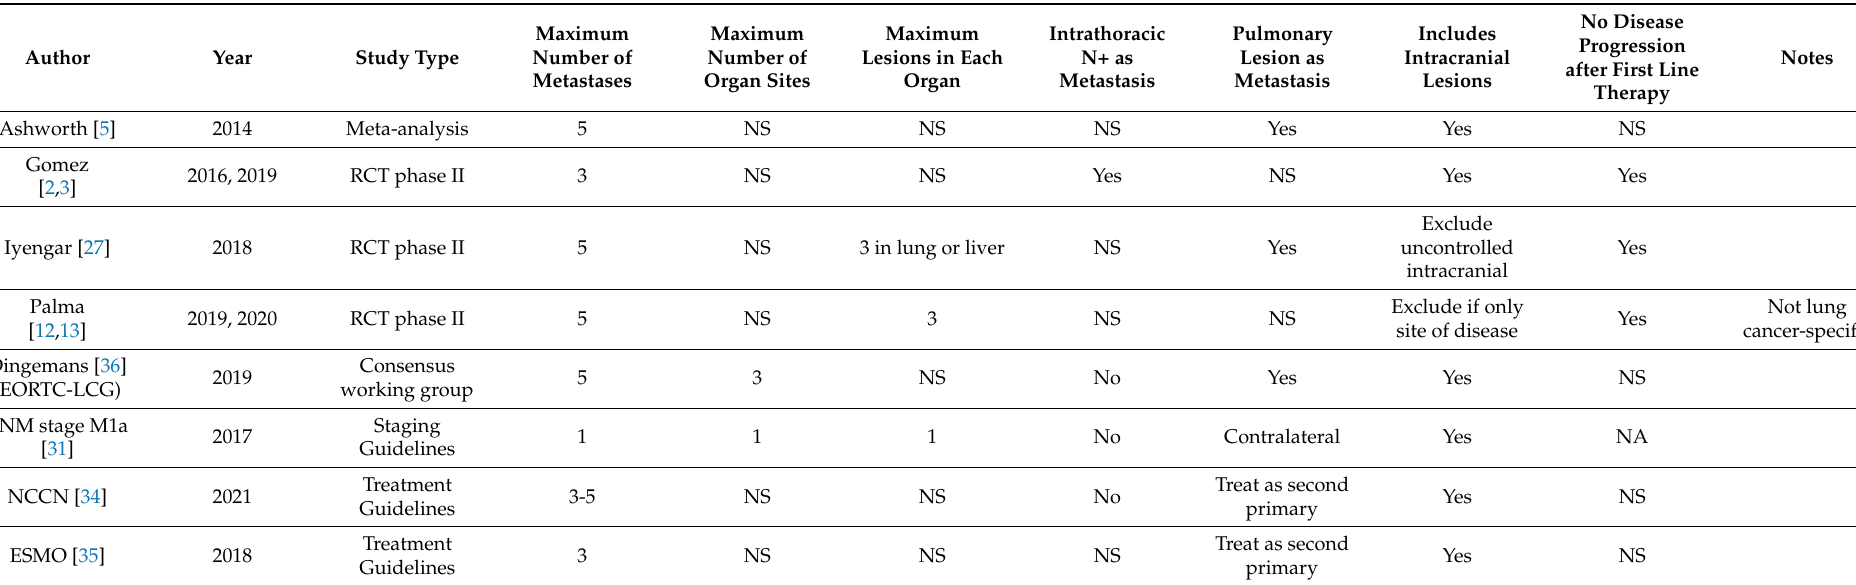
Table 1. Comparison of Recent Definitions for Oligometastatic Non-Small Cell Lung Cancer in Clinical Trials, National Treatment Guidelines, and Consensus Definitions. Modern definitions for oligometastatic non-small cell lung cancer have varied